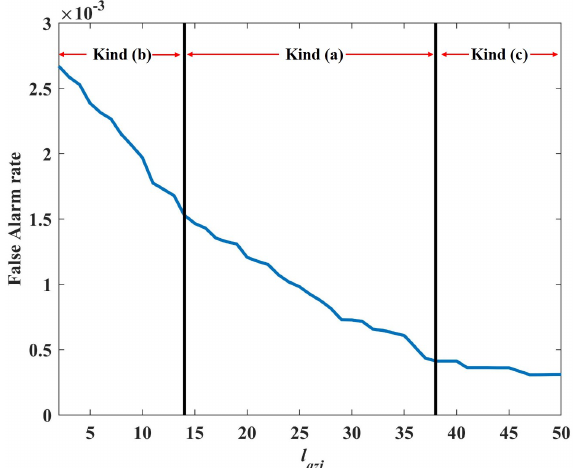
Figure 17. False alarm rate versus l azi when R Minpts = 0.28. The curve is divided into three parts according to the clustering accuracy results kind (a), kind (b) and kind